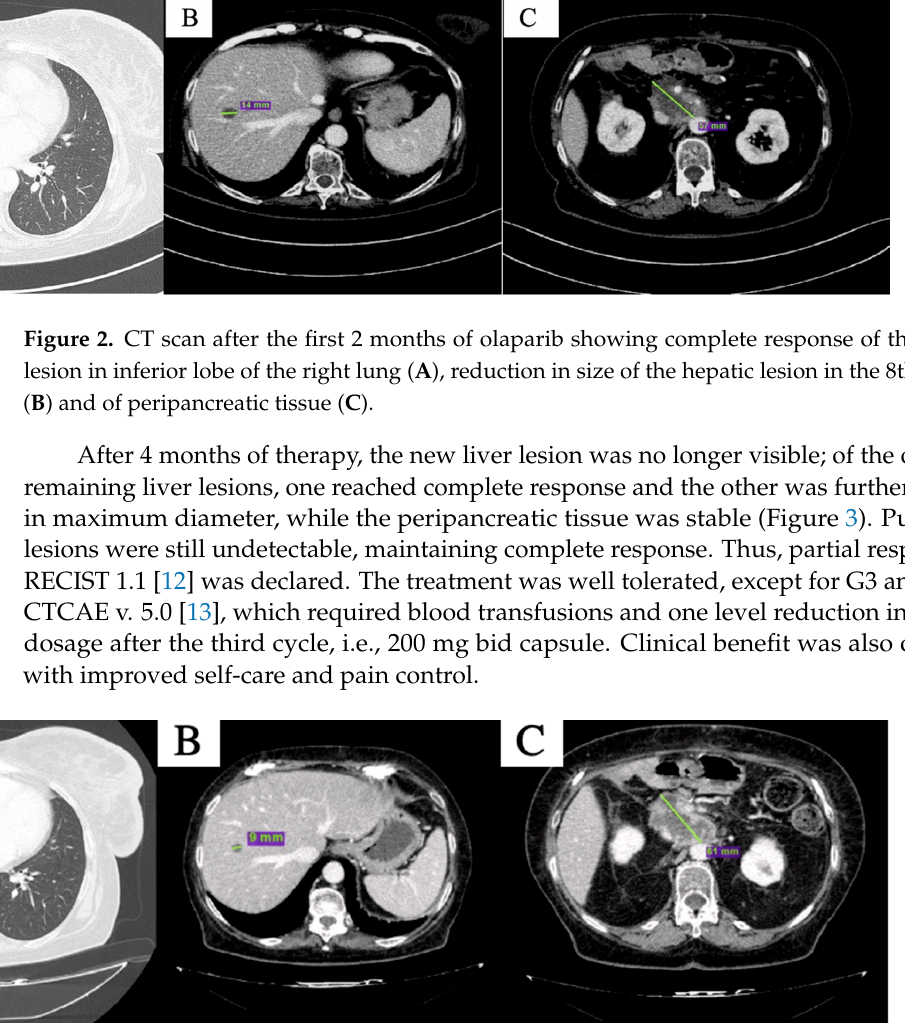
Figure 1. Baseline CT scan showing nodular lesion in inferior lobe of the right lung ( A ), hepatic lesion in the 8th segment ( B ) and peripancreatic tissue ( C ).